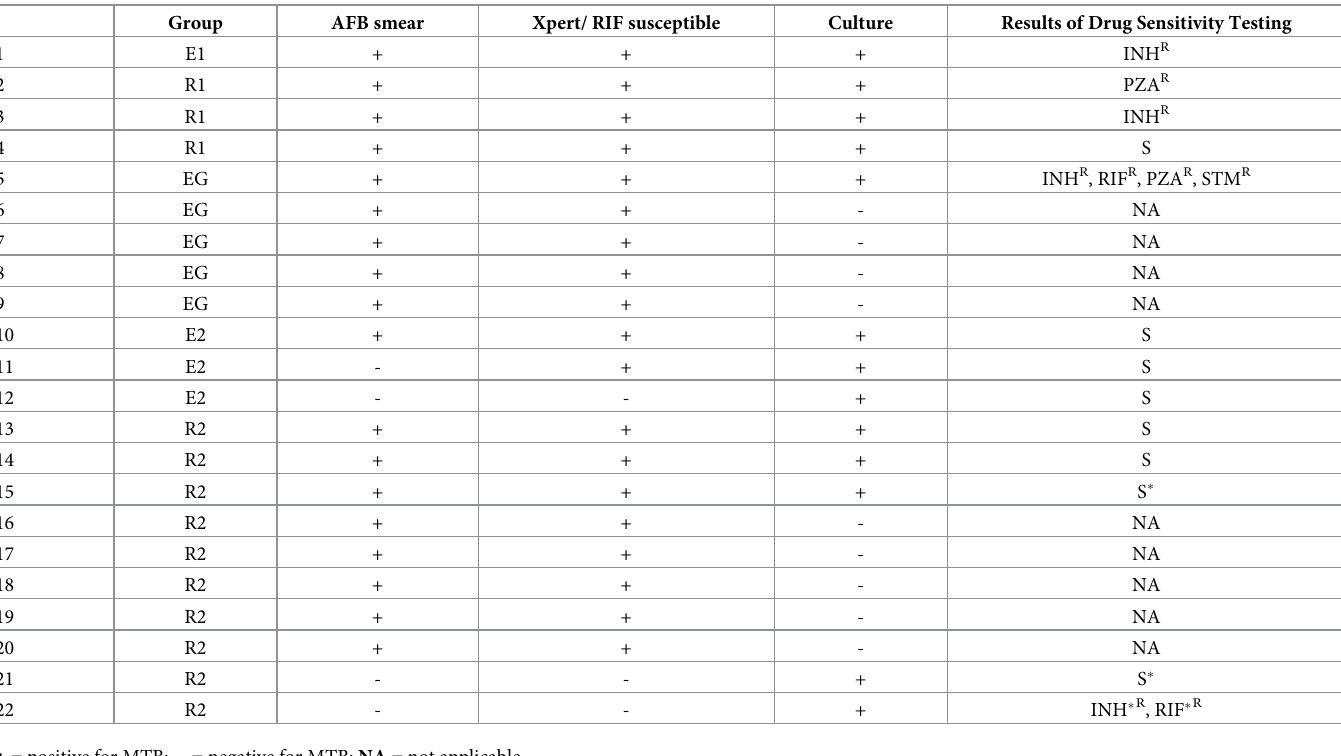
Table 3. Diagnostic results for bacteriologically-confirmed PTB